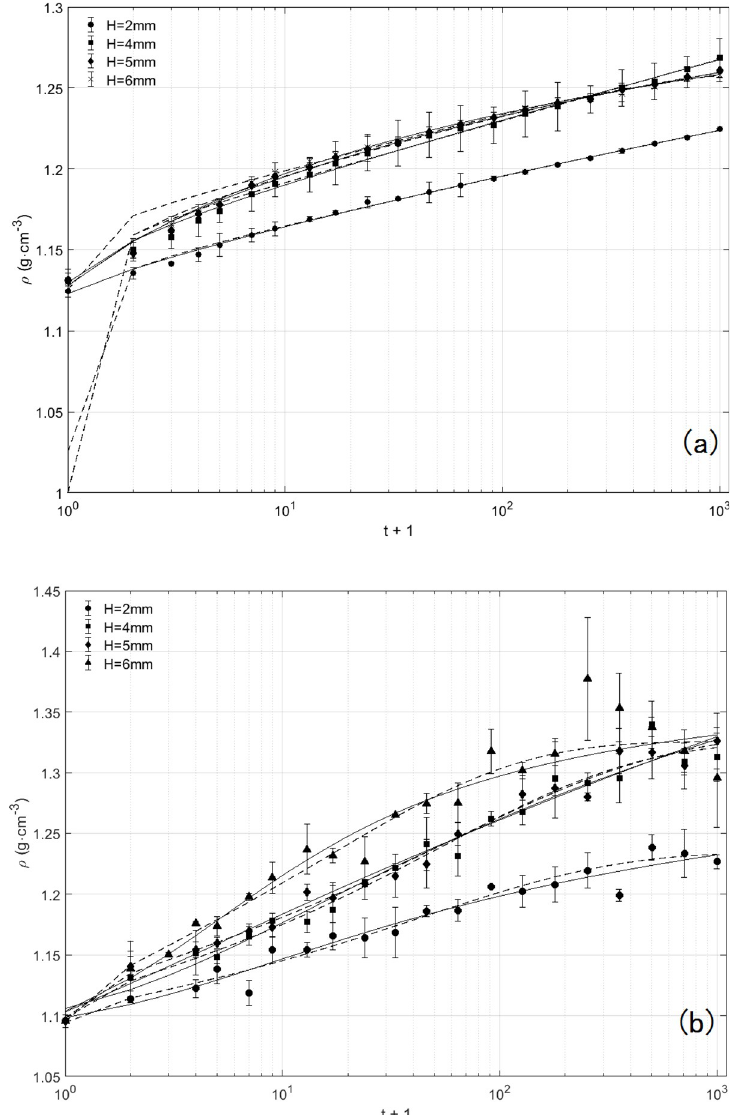
Fig 4. Temporal evolution of packing density for various drop heights. (a) Temporal evolution of the overall packing density: H = 2 mm (•), H = 4 mm ( ■ ), H = 5 mm ( ◆ ) and H = 6 mm ( ▲ ). Each curve is an average of 3 separate experimental runs and error bars represent the rms variation between runs. The solid lines are least square fits to the inverse-logarithmic function, namely Eq (1), and the dotted lines are fits to the stretched exponential function, namely Eq (2). Approximate 10% of the measurements are plotted for clarity (S1 File). (b) Temporal evolution of the local packing density obtained from the 8th tube from the bottom up at the same drop heights as (a) (S2